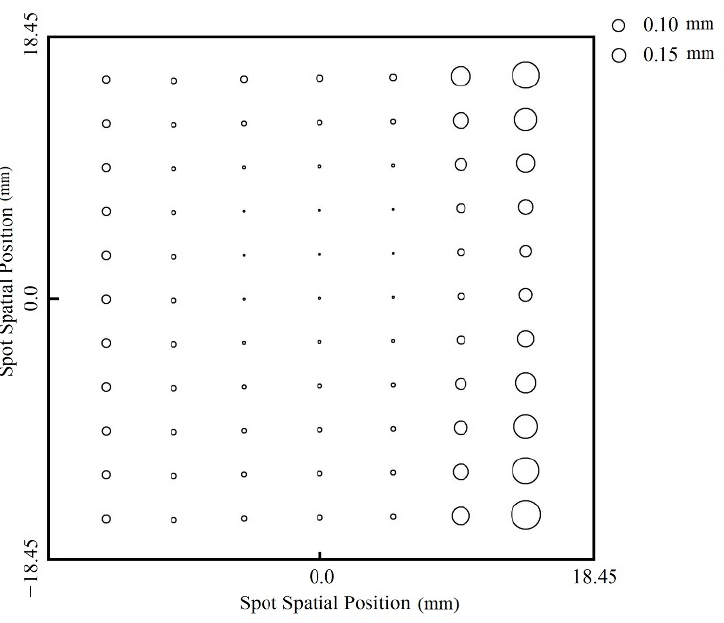
Figure 5. Y-spot radius at the position of the detector.